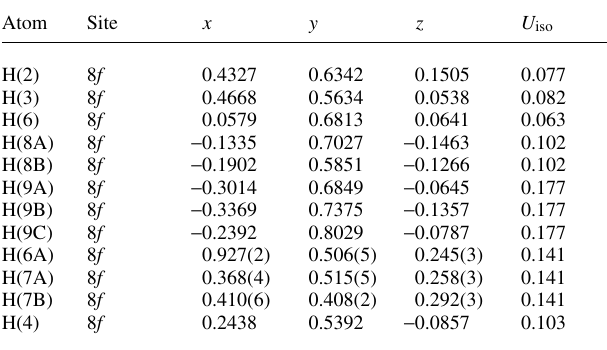
Table 2. Atomic coordinates and displacement parameters (in Å 2 )